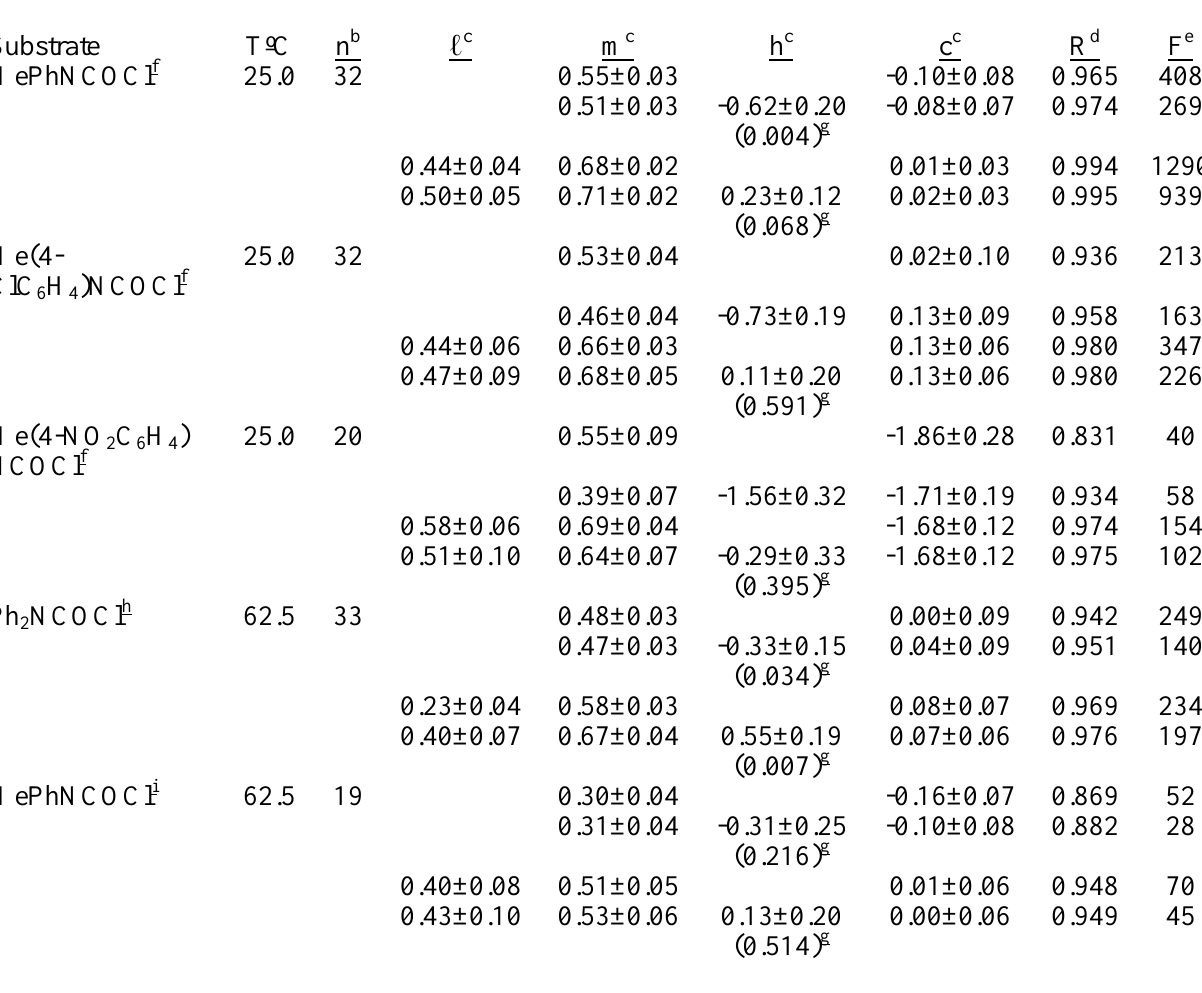
Table 1. Correlations a of the specific rates of solvolyses of three N-methyl-N-arylcarbamoyl chlorides and N,N-diphenylcarbamoyl chloride using the original and extended forms of the Grunwald-Winstein